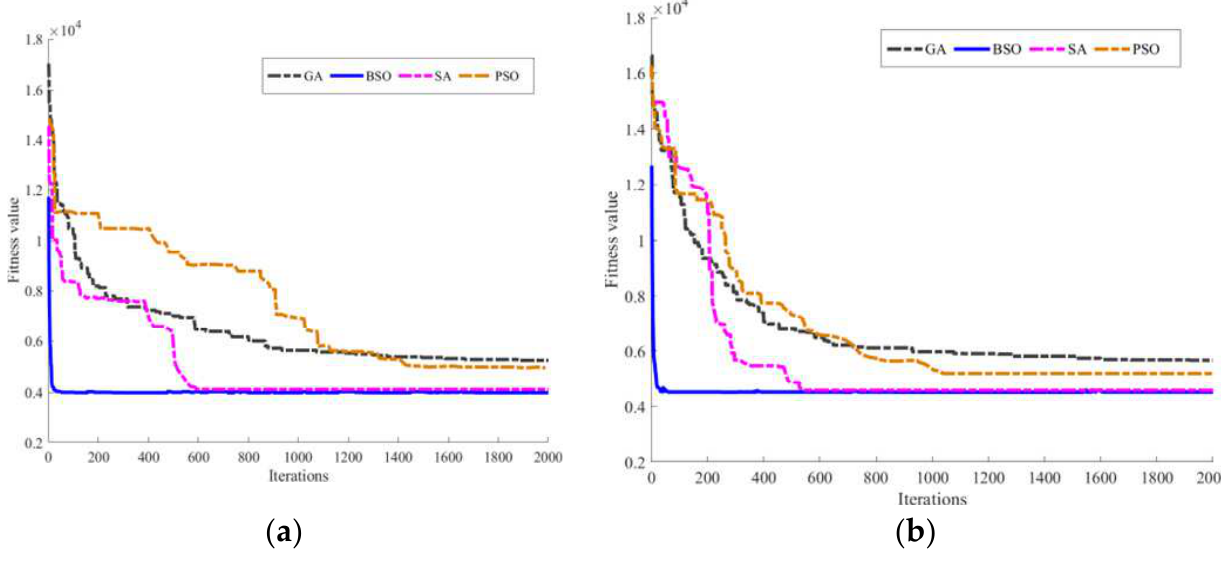
Figure 13. Experiment results of kiwifruit picking task planning. ( a ) Scenario 1 convergence curve. ( b ) Scenario 2 convergence curve.